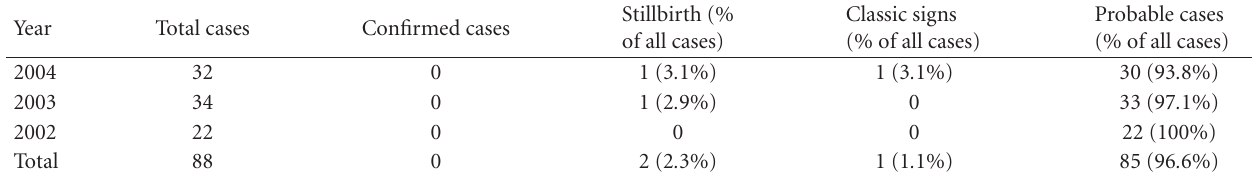
Table 1: Reported congenital syphilis cases in Detroit during years